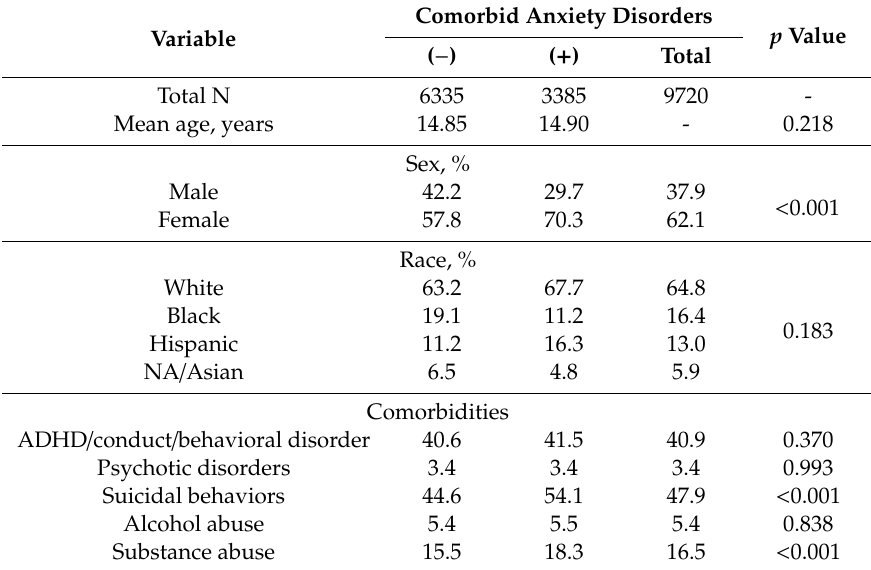
Table 1. Demographic and comorbidities in bipolar depression